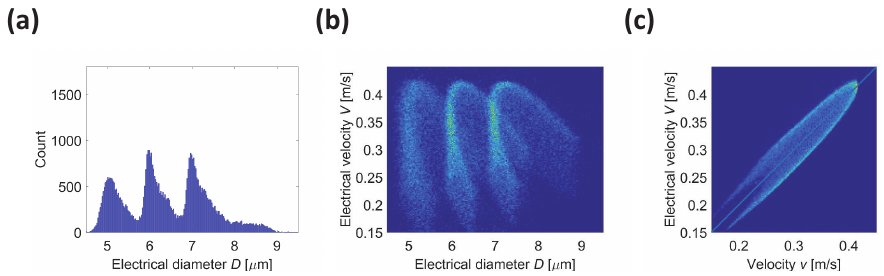
Figure 5. Facing electrode chip operated using the conventional wiring scheme. Virtual experiment relevant to a mixture of insulating beads with 5, 6, and 7 µ m diameter (data stream F conv ( a ) Histogram of the electrical diameter D ; ( b ) Density plot of electrical velocity V vs. electrical diameter D ; ( c ) Density plot of electrical velocity V vs. velocity v